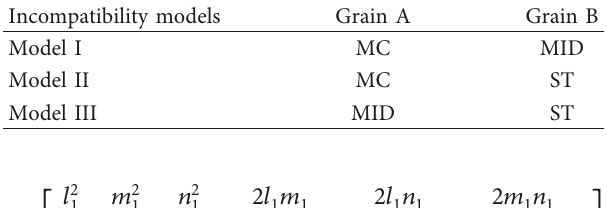
Figure 4: Mises stress (GPa) distribution on three incompatibility bicrystal